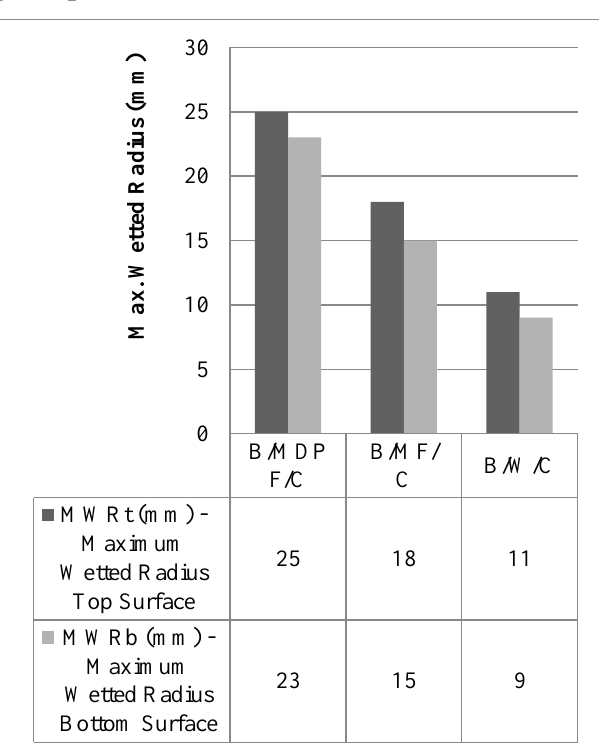
Fig. 3. Maximum wetted radius of trilayer knitted